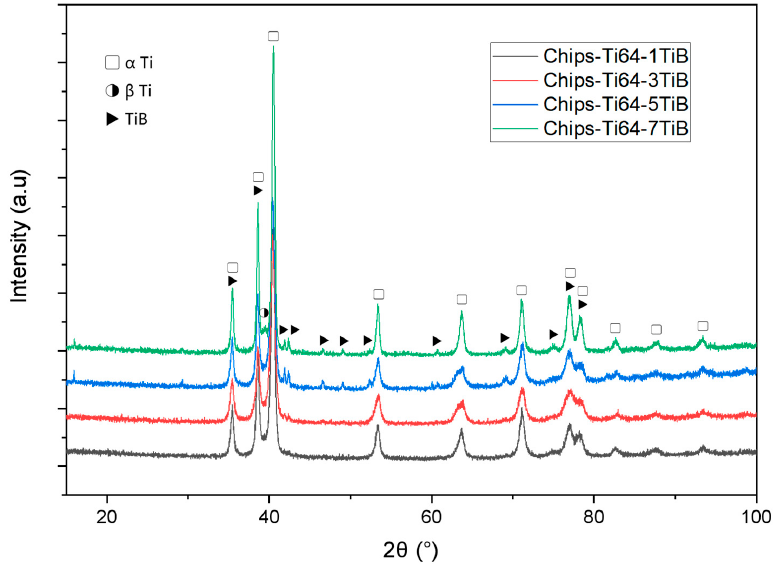
Figure 4. XRD patterns of 1250 °C hot-pressed Ti-6Al-4V composites with x vol.% Boron (x = 1, 3, 5, and 7).